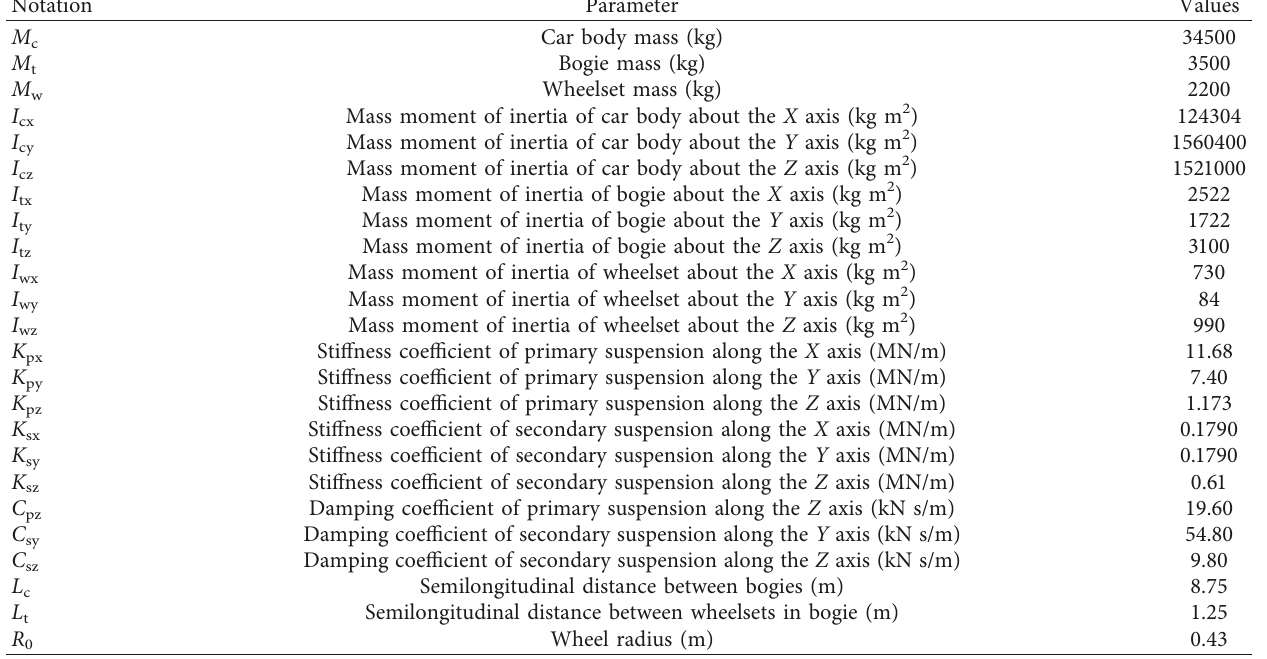
Table 1: Main parameters of railway vehicles used in the